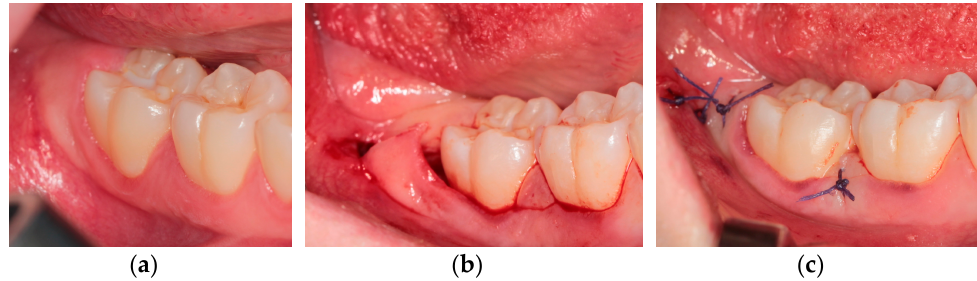
Figure 4. Flap with papilla decapitation: ( a ) pre ‐ operative clinical view; ( b ) intra ‐ operative incisions; ( c ) final suture.